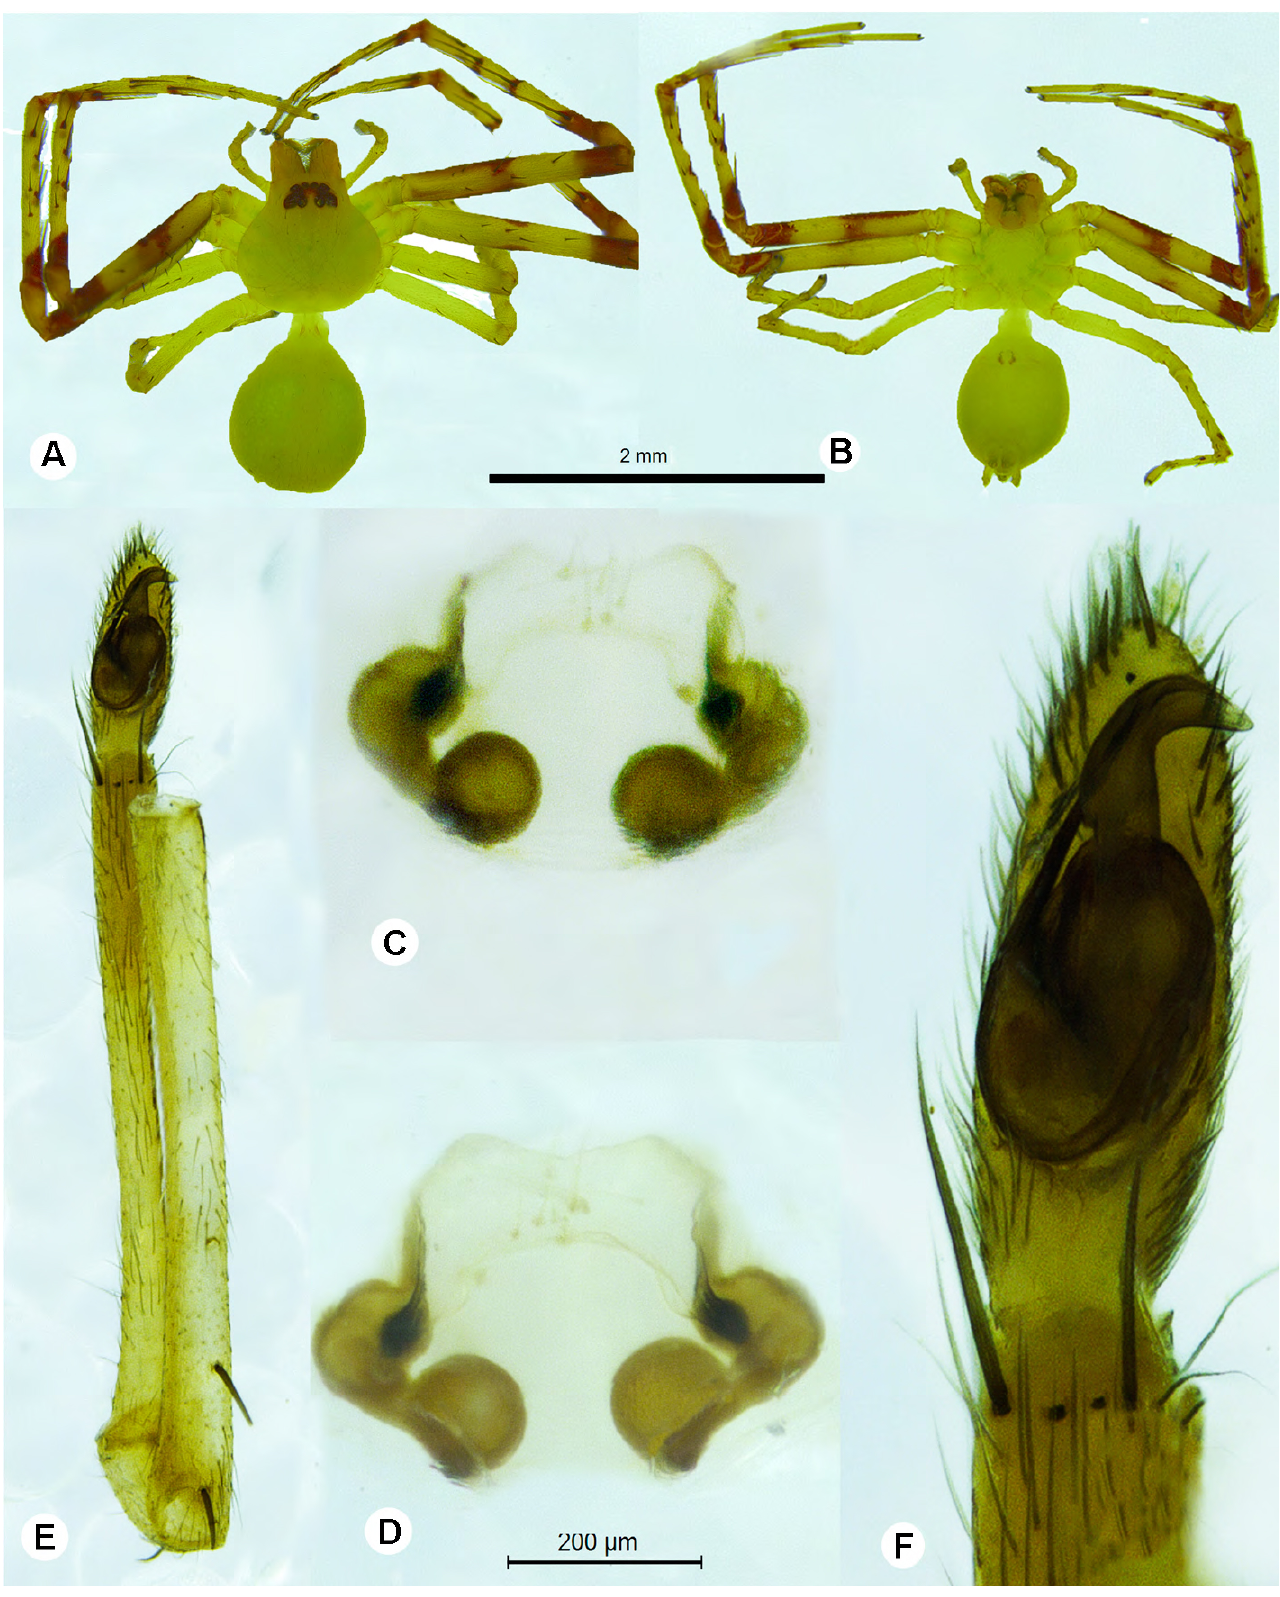
Figure 1. Habitus and reproductive structures of Epidius parvati Benjamin, 2000. A. Female habitus, dorsal view. B. Female habitus, ventral view. C. Epigyne, ventralview. D. Vulva, dorsal view. E. Male palp, entire view. F. Male palp, ventral view of the